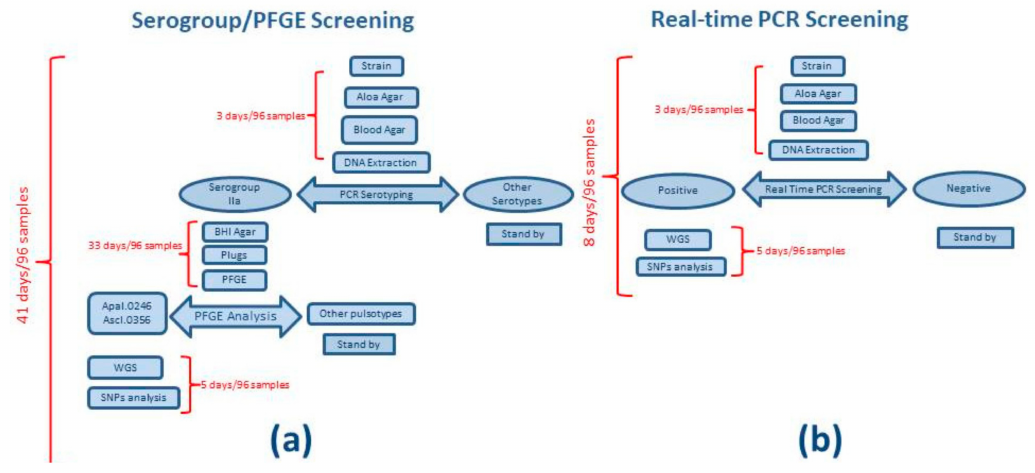
Figure 1. Analysis workflow and turnaround time to analyze 96 samples. Cases ( a ) and ( b ) show time of analysis applying serogroup and PFGE and real-time PCR as screening test to perform outbreak inclusion / exclusion,